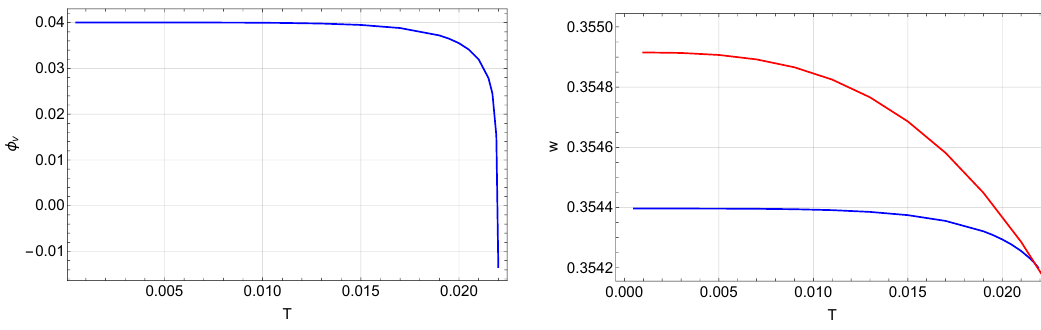
Figure 2 . (left) Plot of the condensate as a function of the temperature. (right) Plot of the free energy of the system in the normal phase (red line) and in the broken phase (blue line) as a function of the temperature. Both plots demonstrate that there is a second order phase transition at T = T c